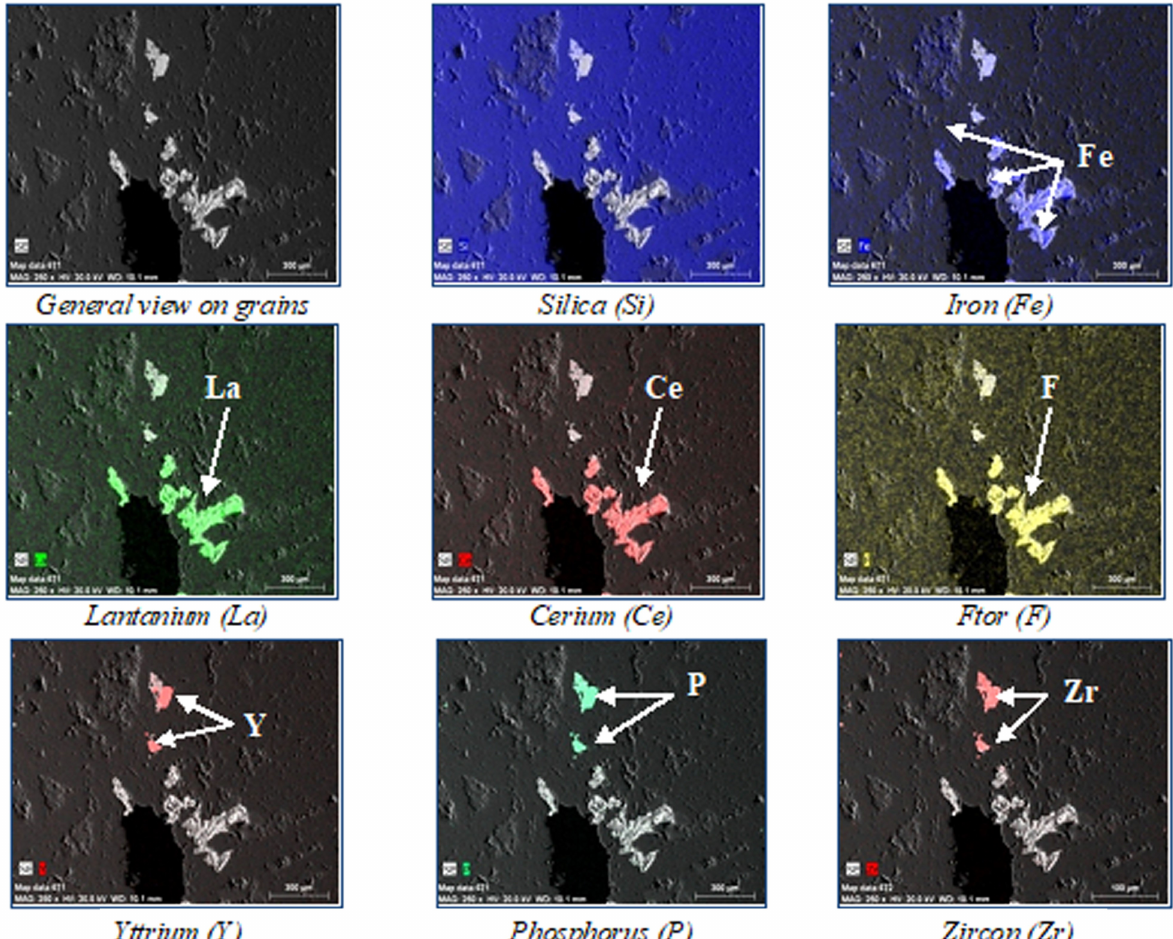
Fig. 15. REE distribution patterns in metasomatic rocks (Zoom